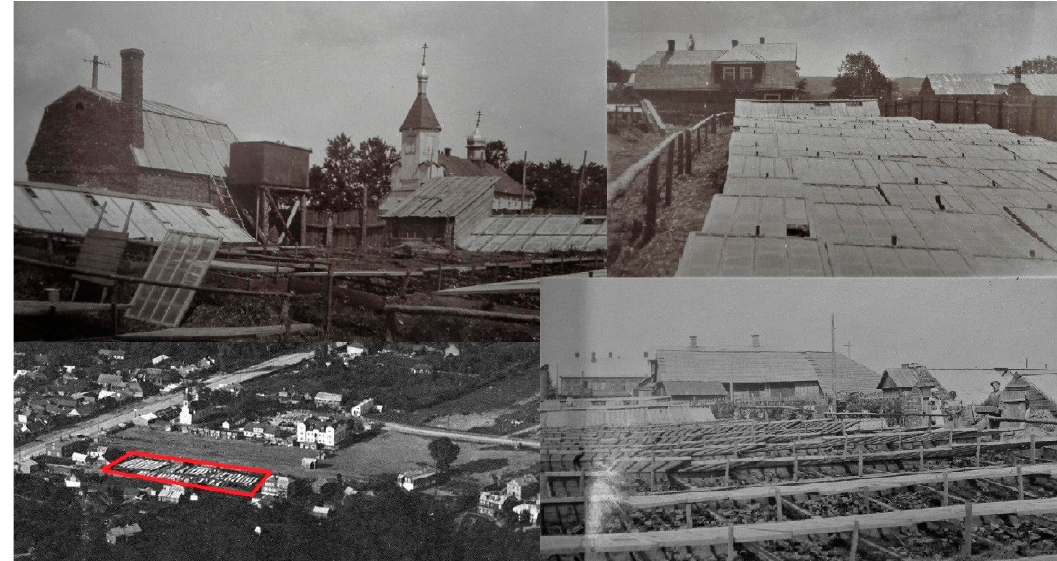
Figure 6. The plot of the greenhouses and hotbeds is marked with red lines (source: Lithuanian Central State Archives).